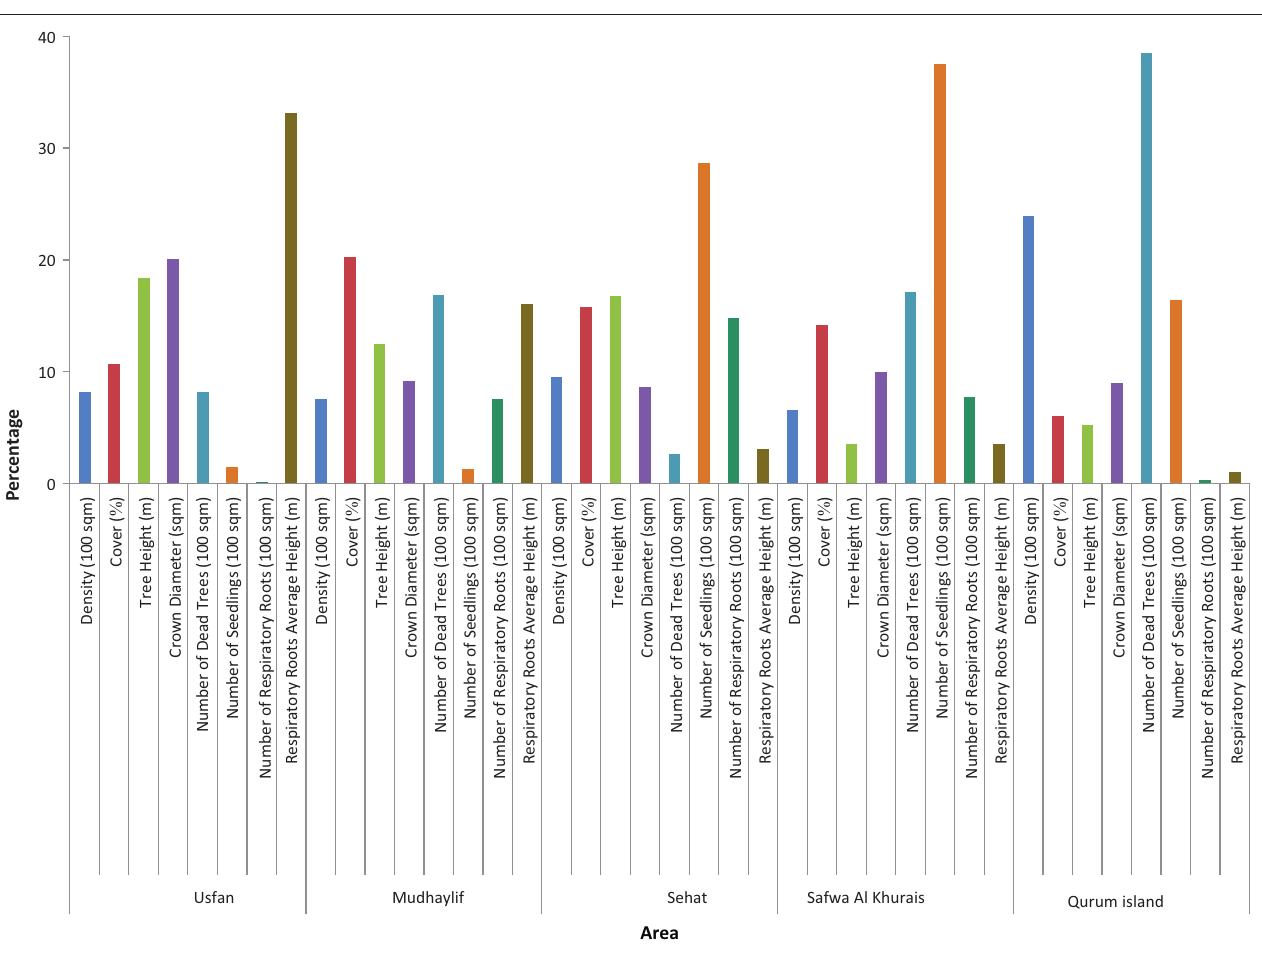
FIGURE 3: The sensitivity analysis total effect ( %